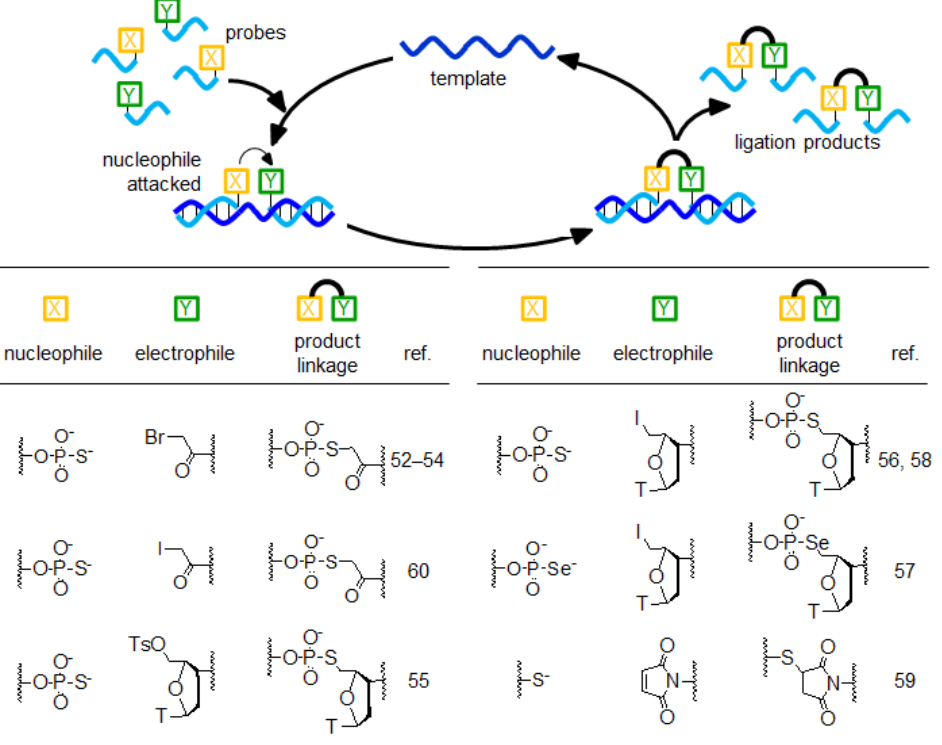
Figure 4. Nucleophilic substitution reaction-mediated